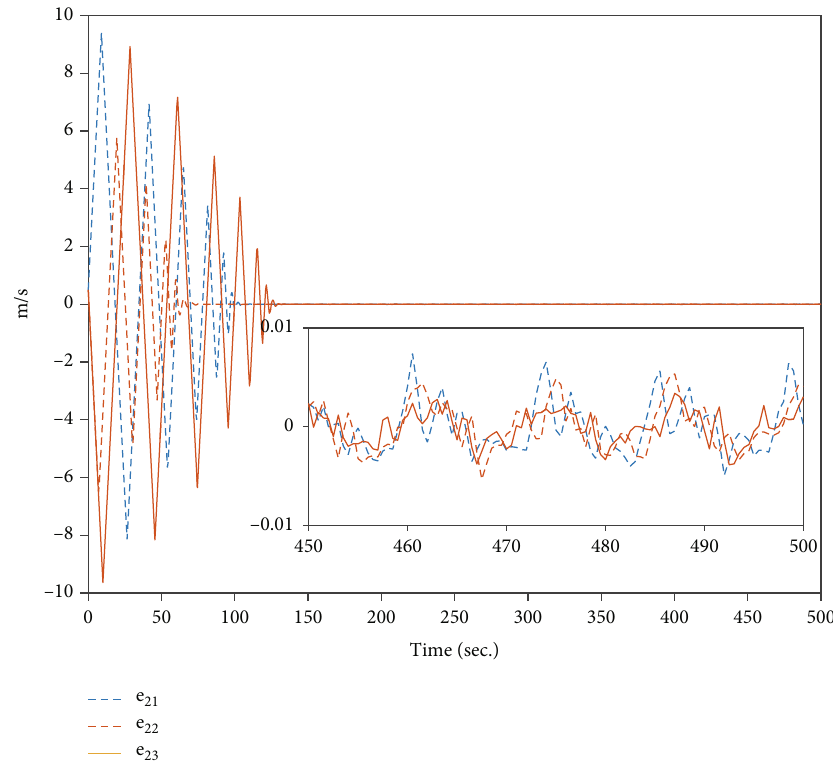
Figure 4: Response curves of velocity tracking